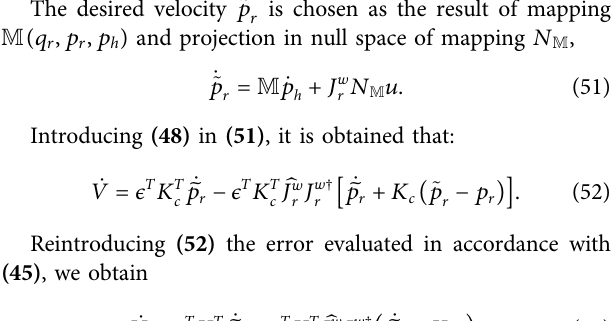
FIGURE 8 | The experimental set-up consisted in the LeapMotion controller, the haptic bracelet and a couple of screen to visualize the Virtual environment and the reconstructed model of tracked hand. In the virtual scene, cubes pseudo-randomly changed their position at the beginning of the single repetition of